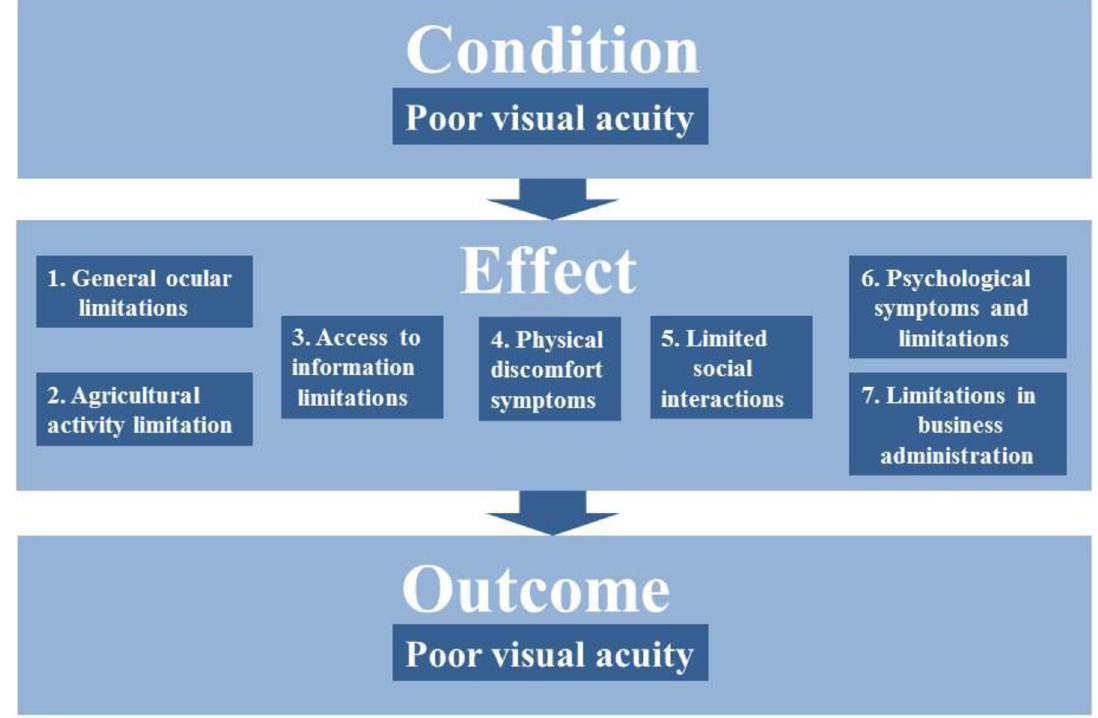
Fig 1. Poor visual acuity and its negative effects on agricultural profitability. The effects are derived from Kandel et al. (6), themes 1, 3, 4, 5, 6 and 7. Theme 2 was excluded because it deals exclusively with the negative effects of wearing glasses, contact lenses and corrective surgery. Source: Own